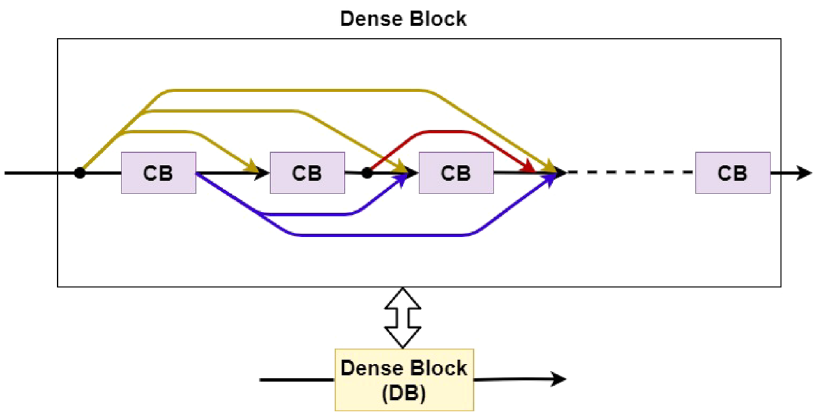
Figure 3. Dense Block (DB). Multiple composite blocks are stacked on top of each other and are connected in a dense fashion. The number of CBs in a dense block is identified to be an important hyperparameter. It is not necessary that all the composite blocks have an equal number of RNN cells.